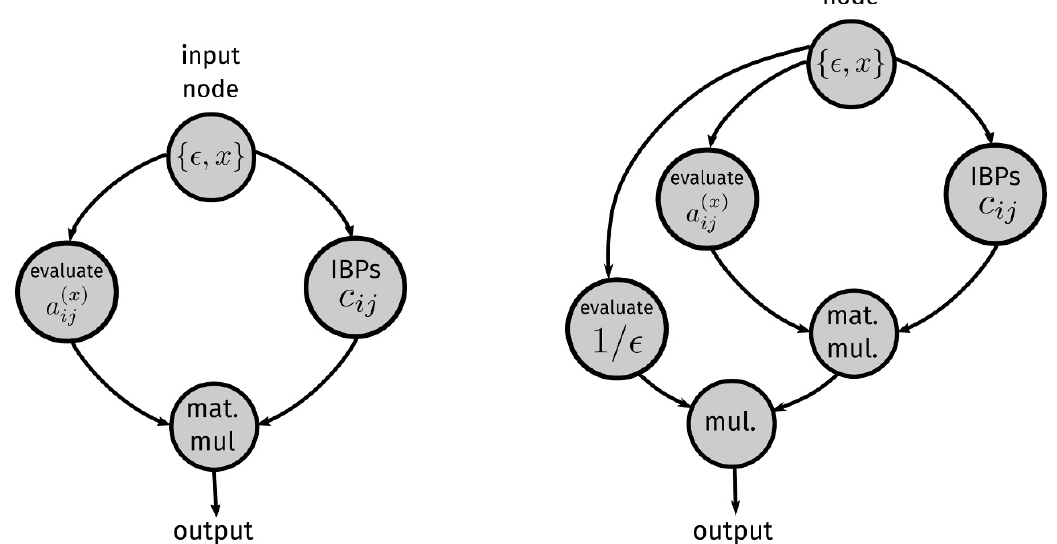
Figure 7 . On the left, a data(cid:13)ow graph representing the calculation of di(cid:11)erential equations satis(cid:12)ed by master integrals. It is similar to the one depicted in (cid:12)gure 5 for the reduction of amplitudes to master integrals. On the right, a data(cid:13)ow graph computing the di(cid:11)erential equation matrices divided by (cid:15) . As explained in section 6.2 we can verify the (cid:15) -form of the di(cid:11)erential equations by checking numerically that the output of the latter graph does not depend on (cid:15)